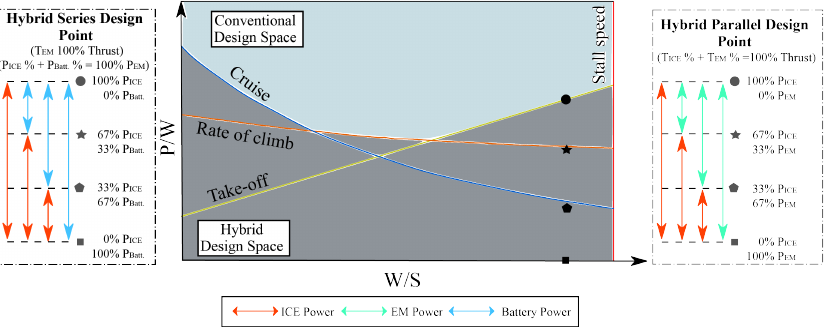
Figure 6. Conceptual Design Methodology: Hybrid Series Constrain